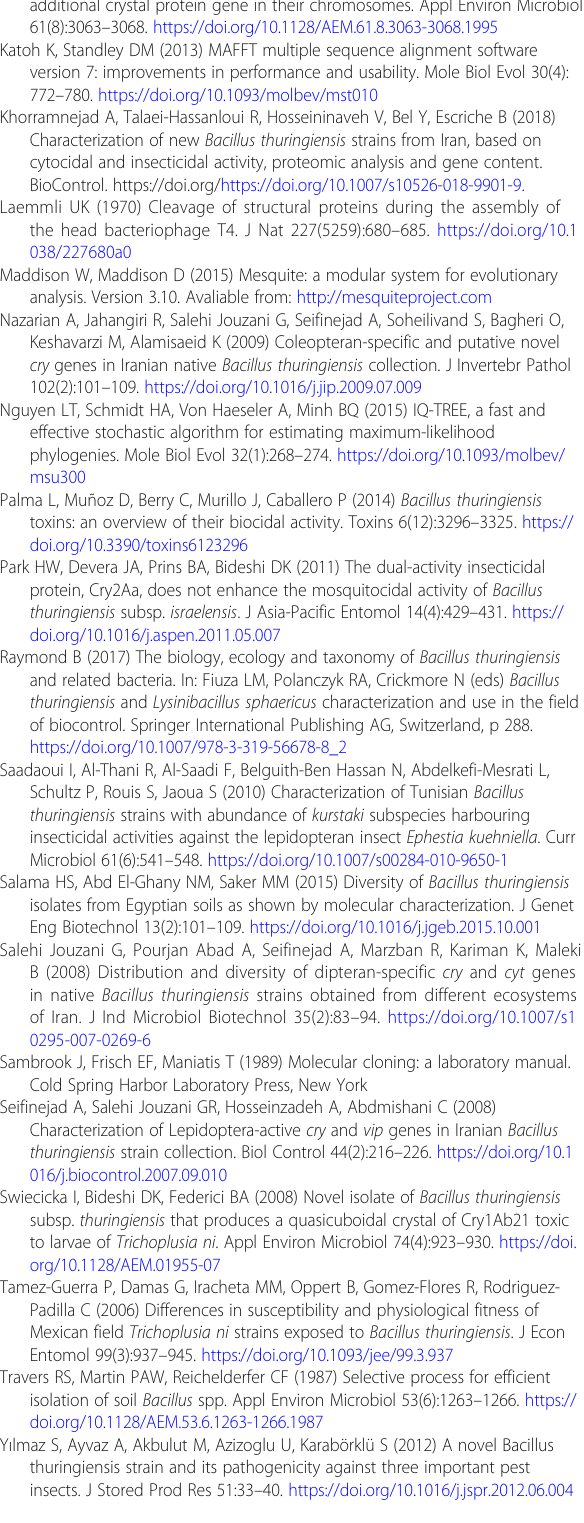
additional crystal protein gene in their chromosomes. Appl Environ Microbiol 61(8):3063 – 3068.